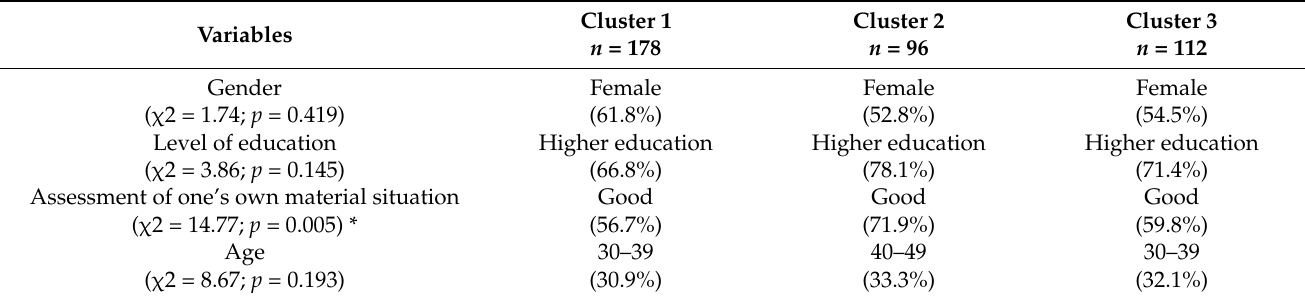
Table 4. Profile of the